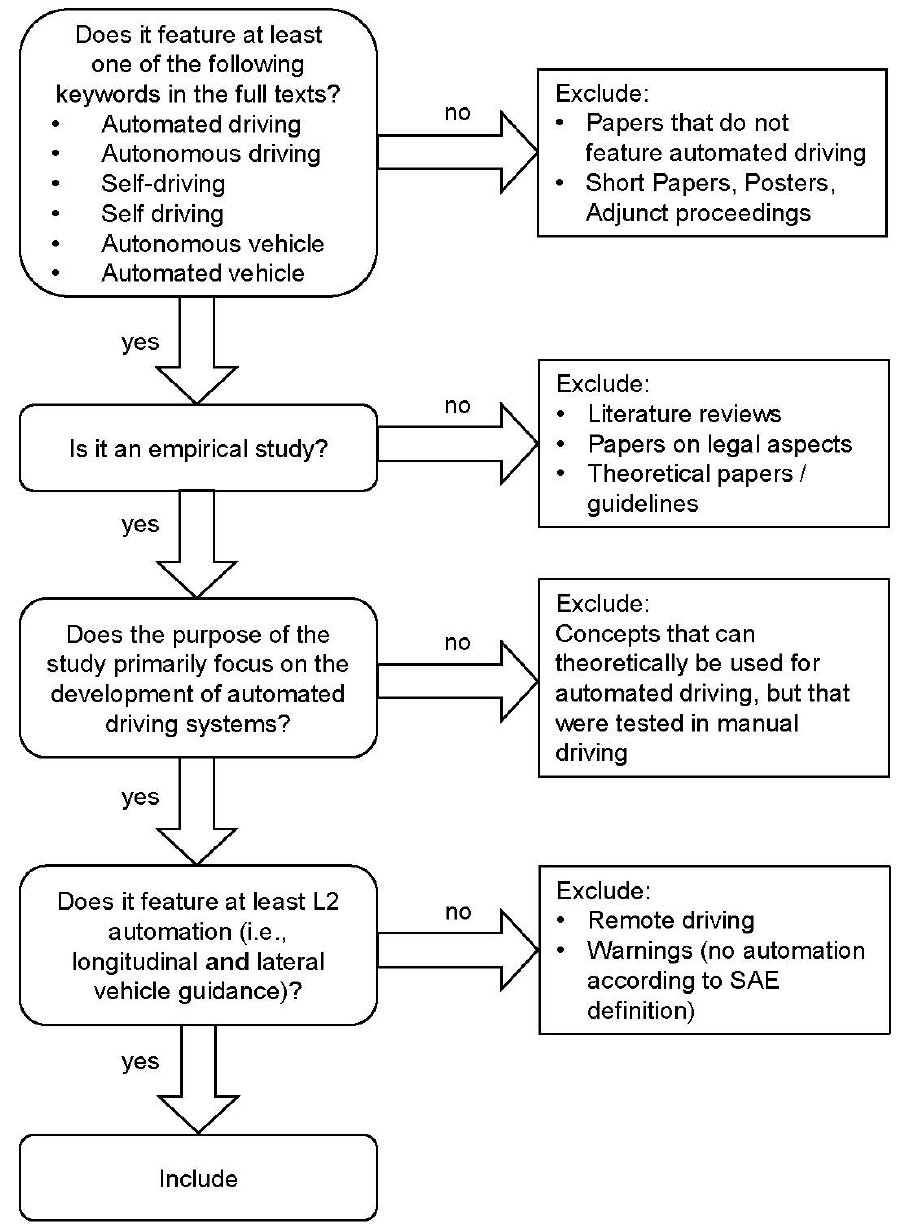
Figure 2. Decision tree for paper